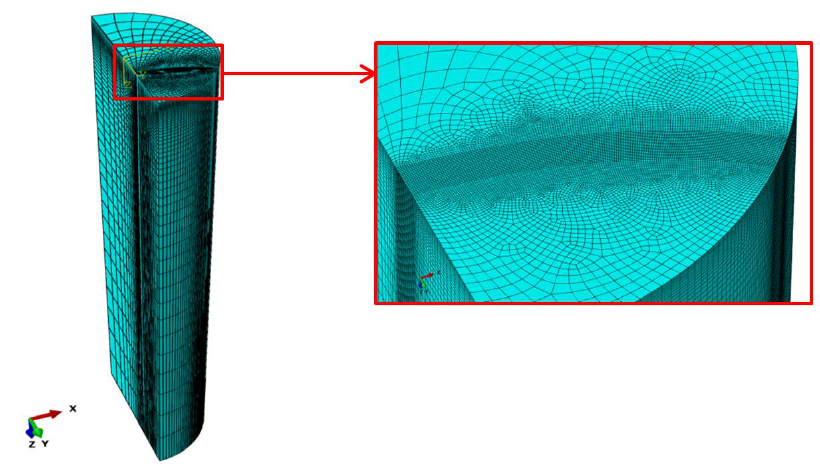
Figure 3. The finite element models of a surface-cracked round bar.